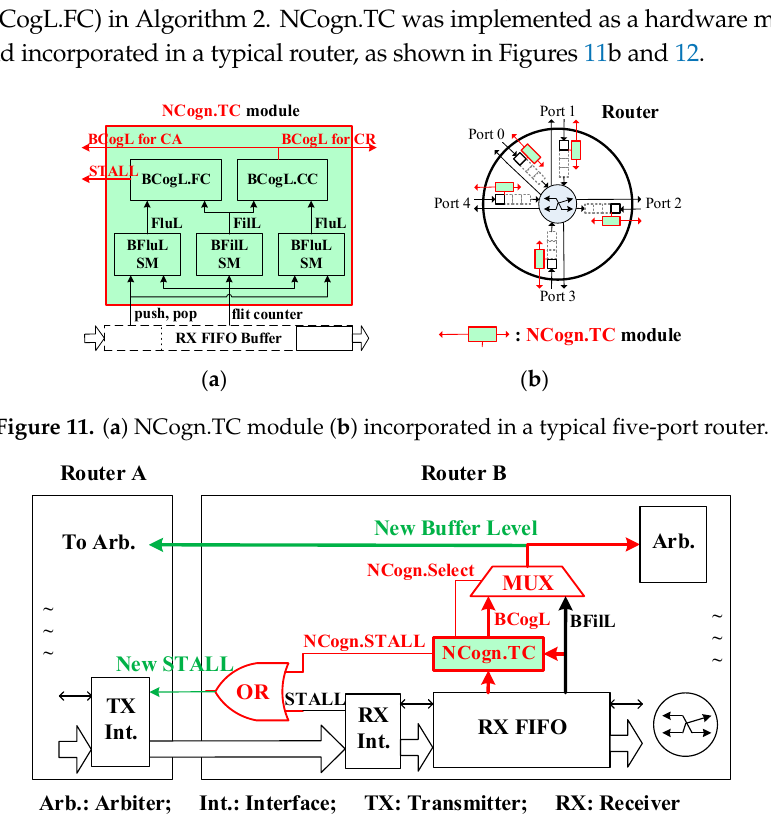
Figure 12. Router incorporated with the Network-Cognitive Traffic Control (NCogn.TC) module using simple OR and MUX logic gates.